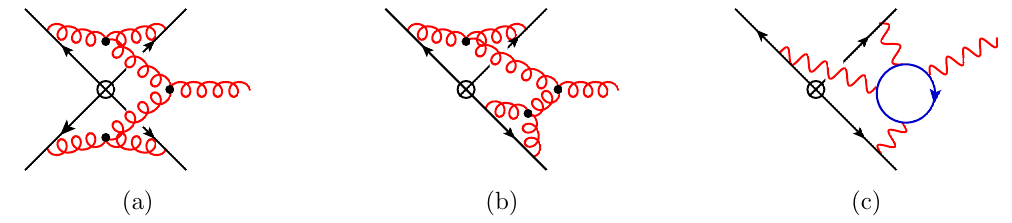
Figure 3. Representative diagrams for the (a) three-loop quadrupole, (b) three-loop tripole, and (c) three-loop Abelian soft